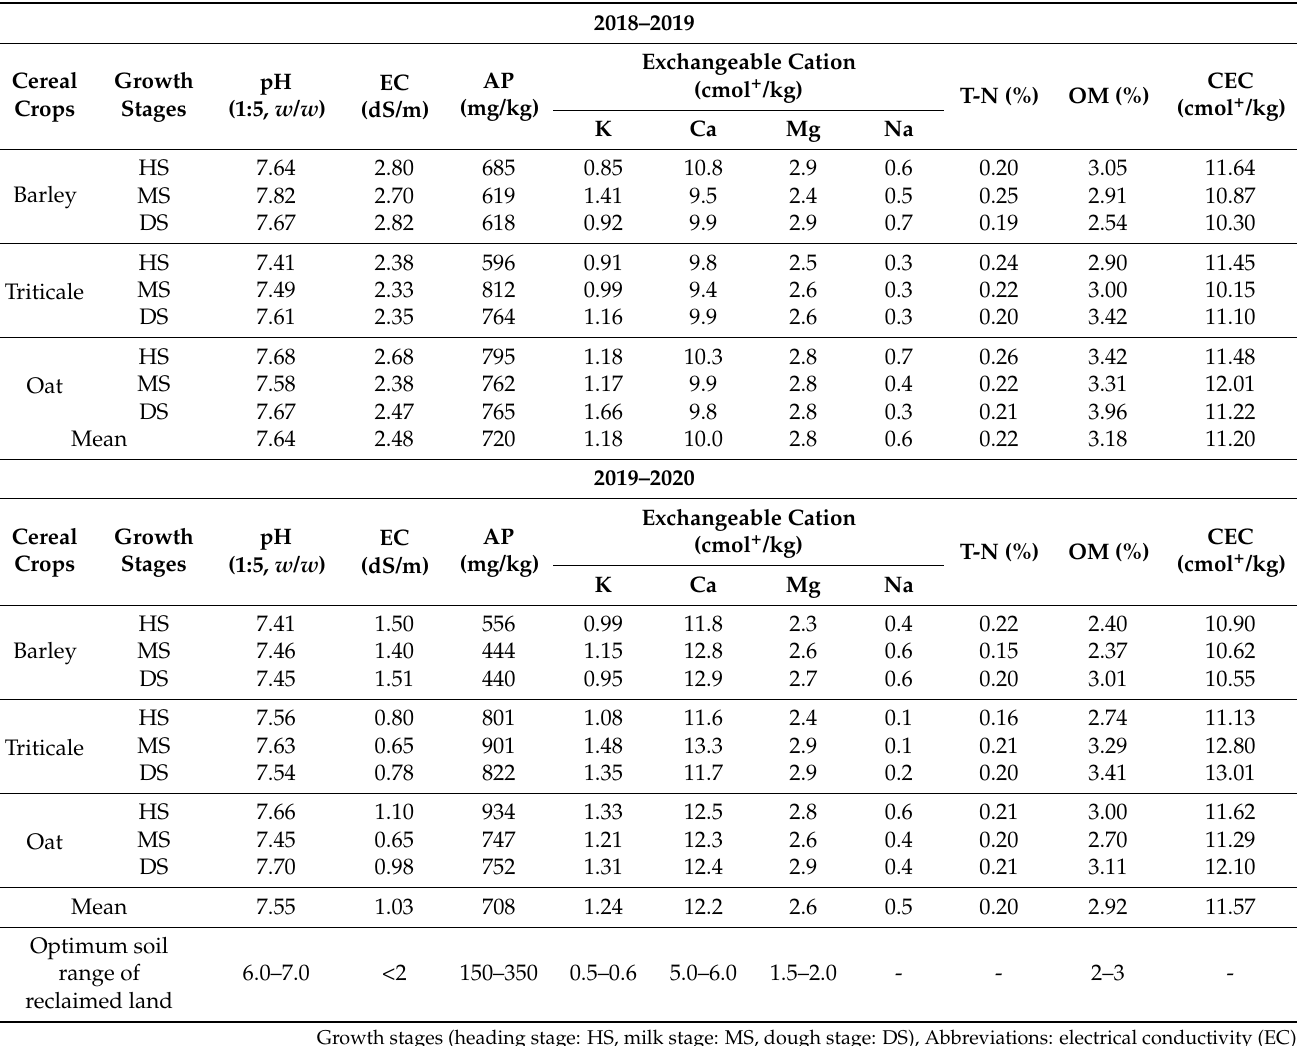
Table 2. Soil chemical characteristics of land reclamation in Korea during the two-year growth